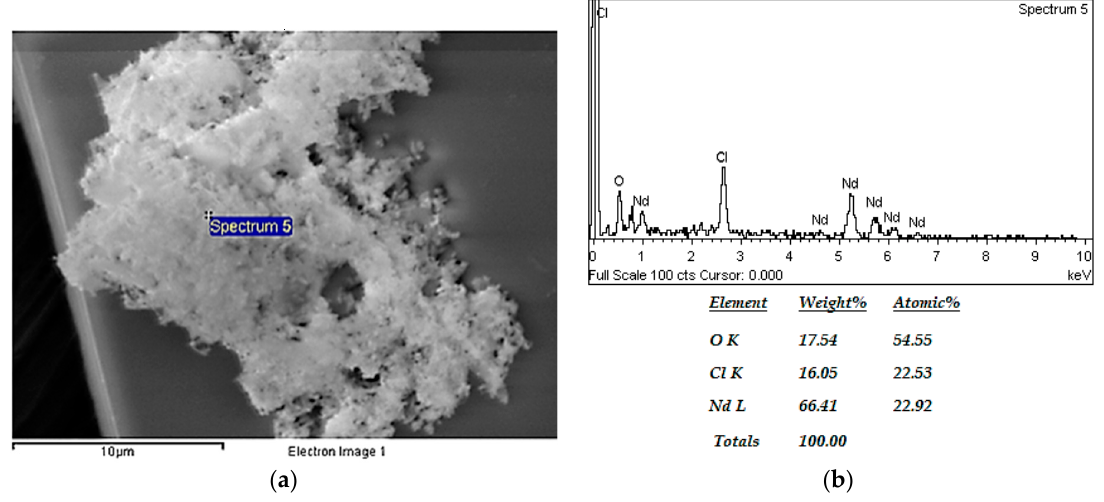
Figure 6. ( a ) SEM image and ( b ) EDS analysis of the electrodeposit.